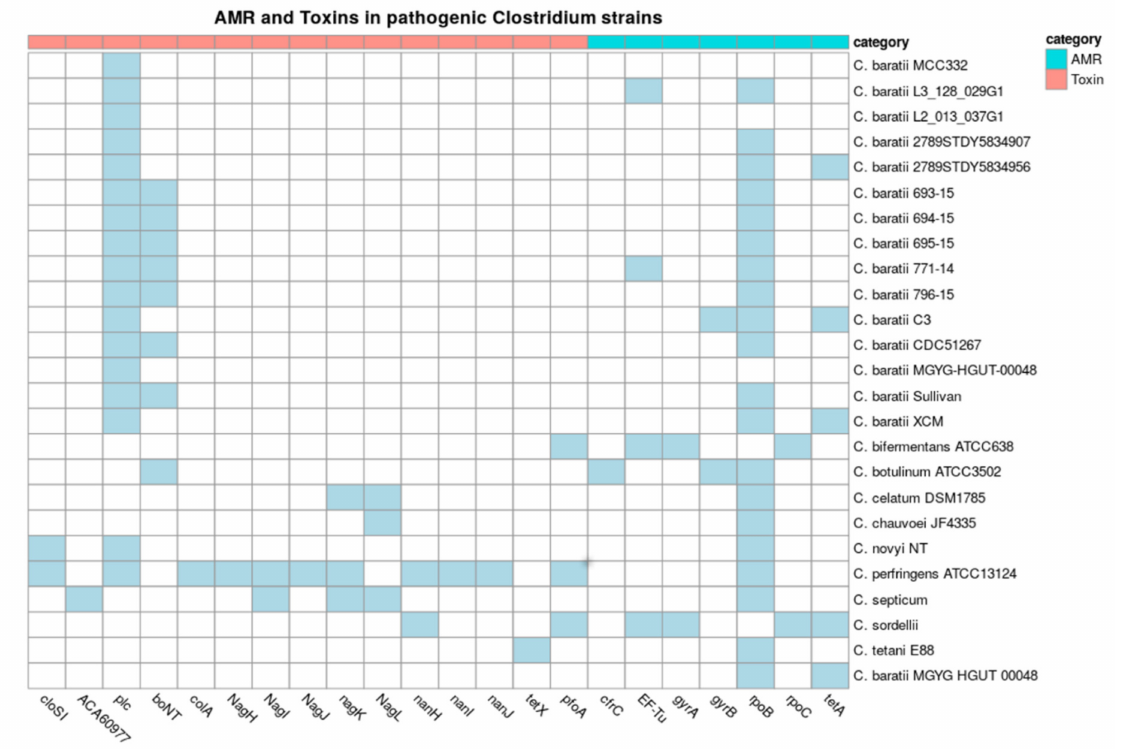
Figure 5. Toxins and Antimicrobial resistance (AMR) in pathogenic Clostridium strains. Presence (in blue) or absence (in white) of toxin and AMR genes in pathogen Clostridium, C. baratii strains. The x-axis represents different toxins, and the y-axis represents the strains. The color on heatmaps represents the toxin group by